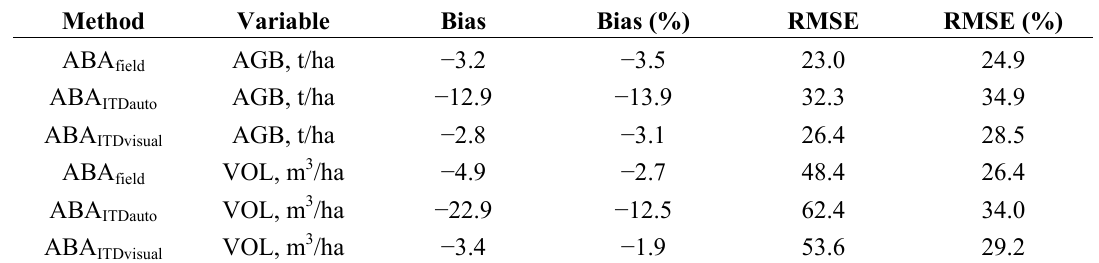
Table 5. AGB and volume imputation accuracies, RMSE and bias, for the test plots (n = 254).